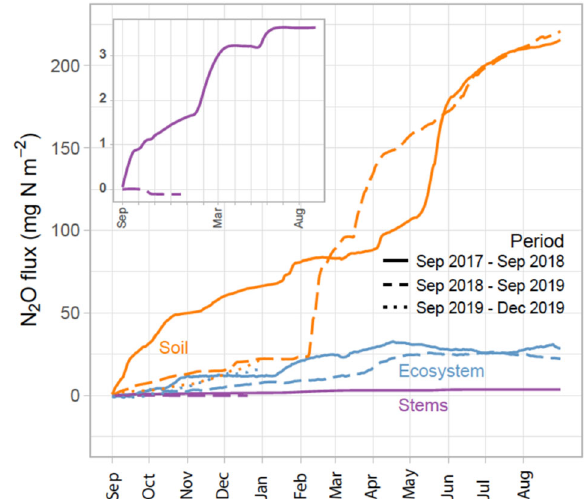
Fig. 3 Cumulative fl uxes of N 2 O from the soil, stems, and the ecosystem (eddy covariance above the canopies). Data from two stem fl uxes are also plotted in the inset. Notice that the stem fl uxes have been measured from Sept 2017 to Dec